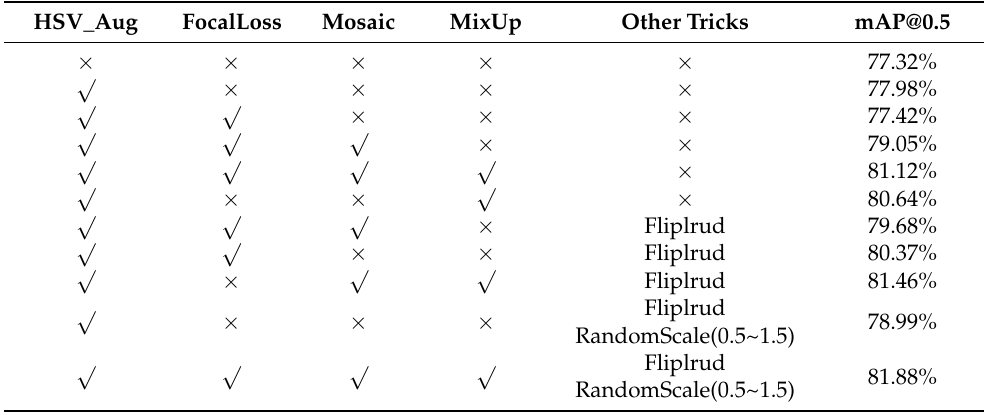
Table 3. R-Yolo 5 with different